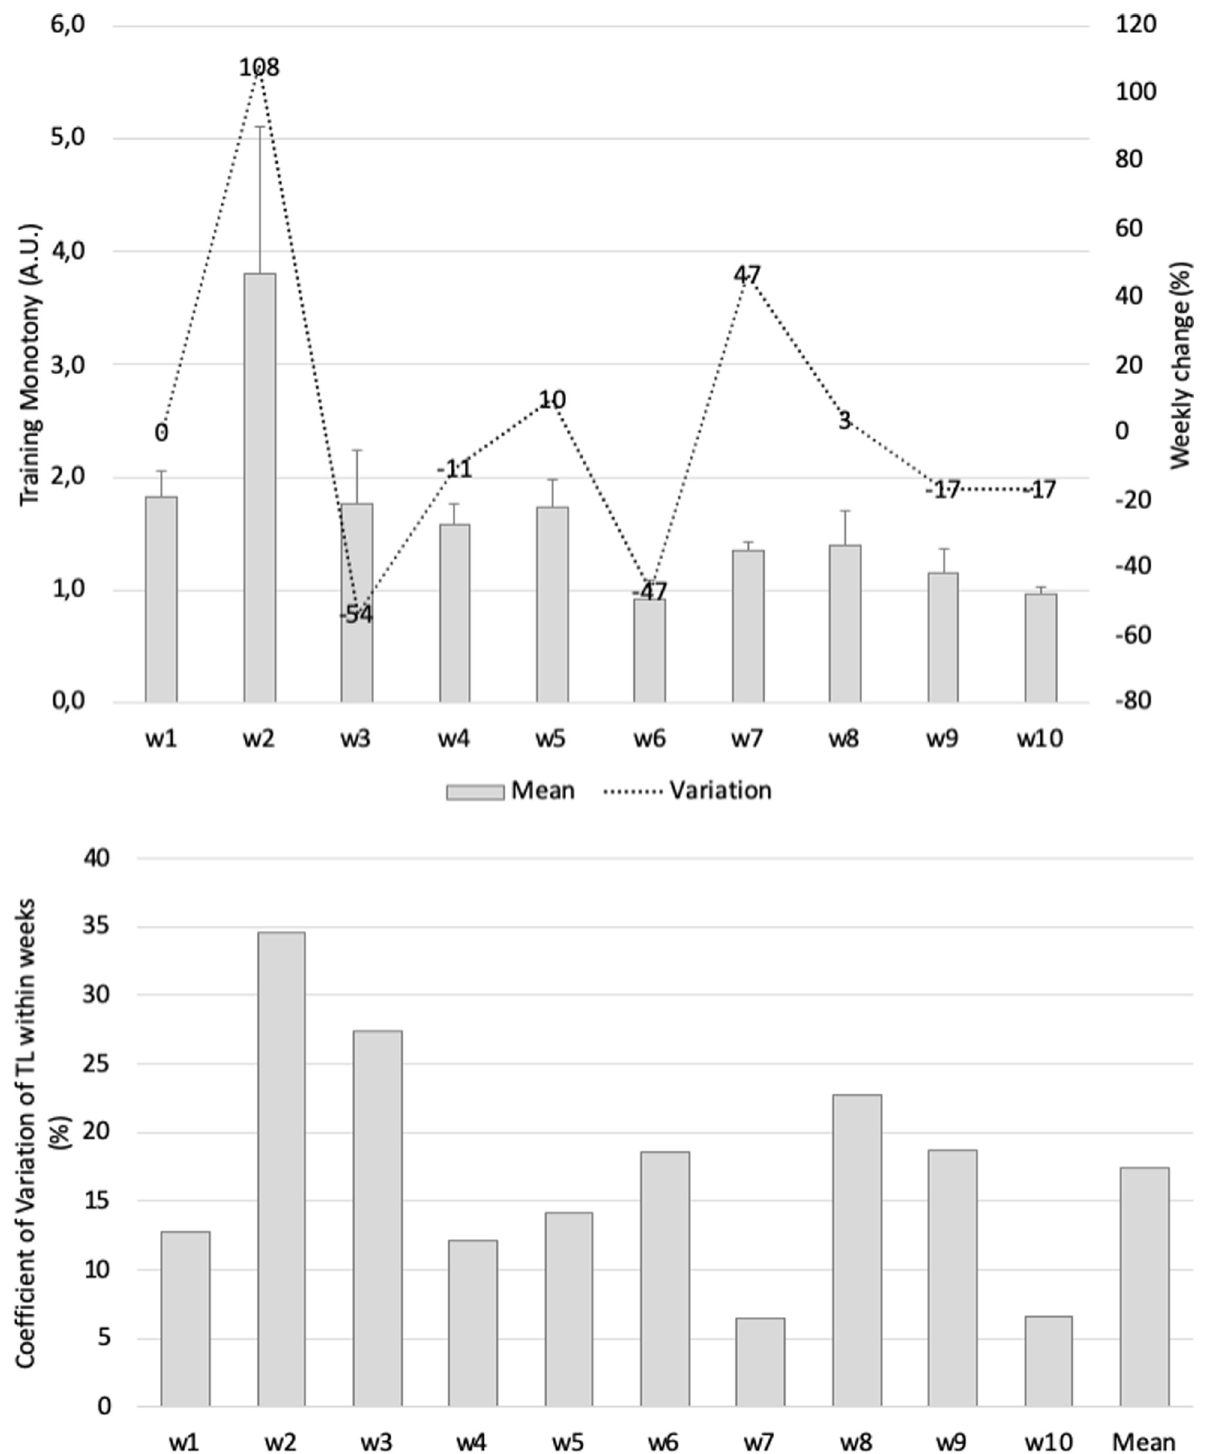
Fig 2. (a) Mean (SD) and weekly changes (%) in weekly training monotony during the 10-week period and (b) within-week monotony variations (CV%) and between-weekly monotony variations (CV%).